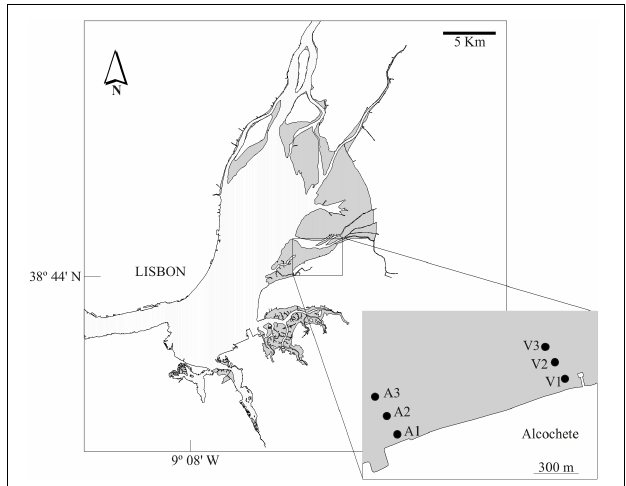
FIGURE 1 | Study area. Sampling stations identified by the letters in the box, gray areas represent intertidal